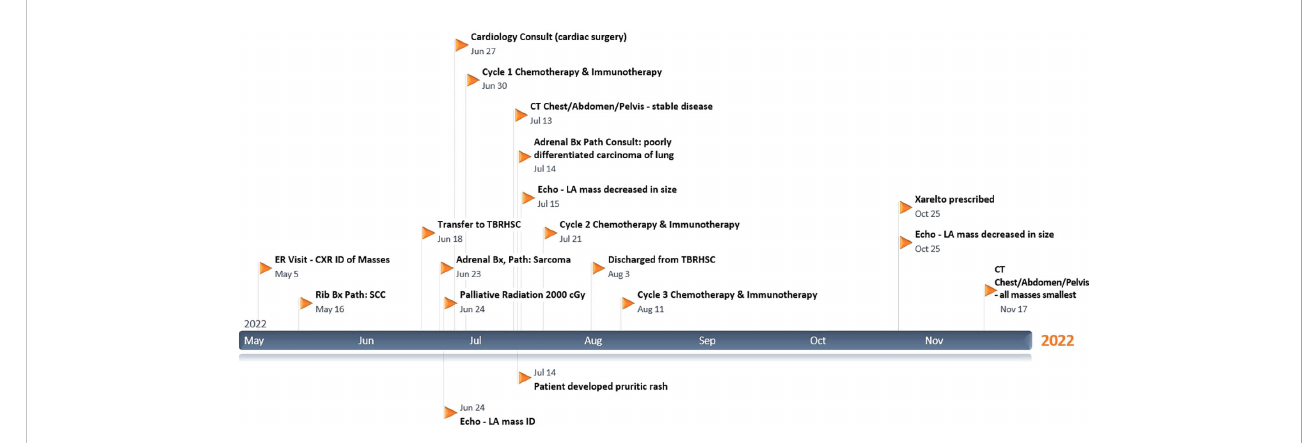
FIGURE 1 Milestone Timeline with data from the related episodes of